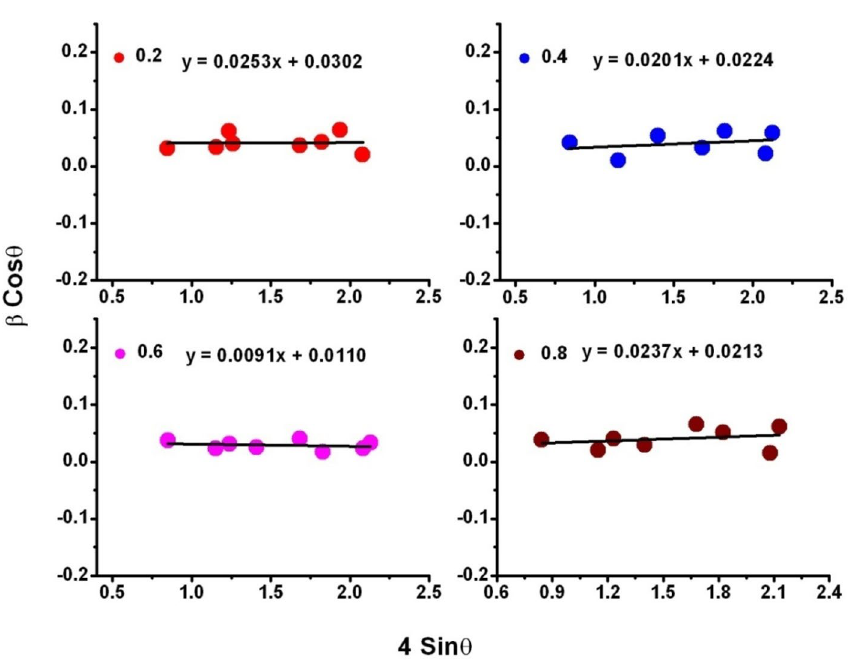
Figure 3. W–H plots of SLFO